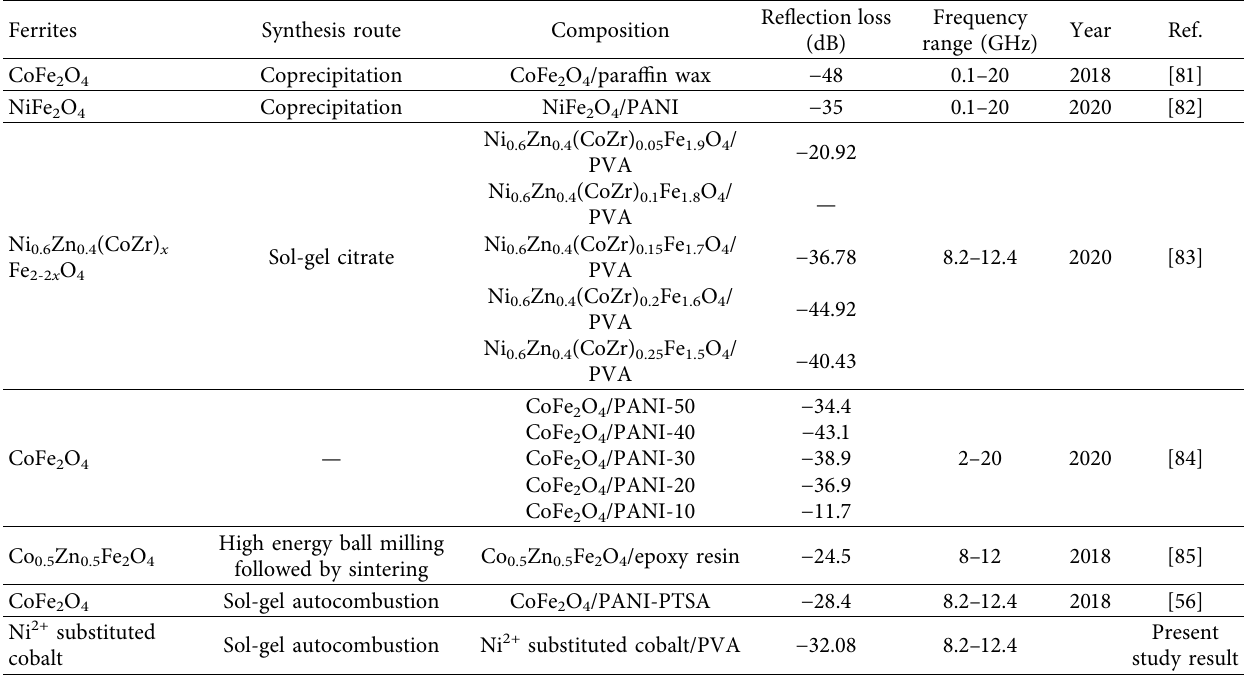
Table 7: Comparison of EMI shielding properties obtained in the present study with that of the various ferrites reported in the literature.